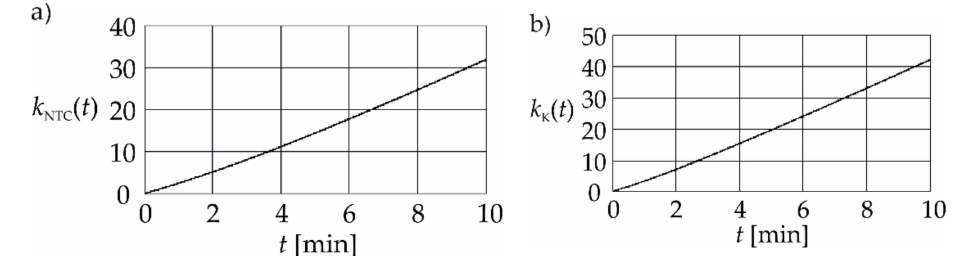
Figure 5. Impulse responses obtained for the negative temperature coefficient NTC ( a ) and K-type thermocouple ( b ) sensors.